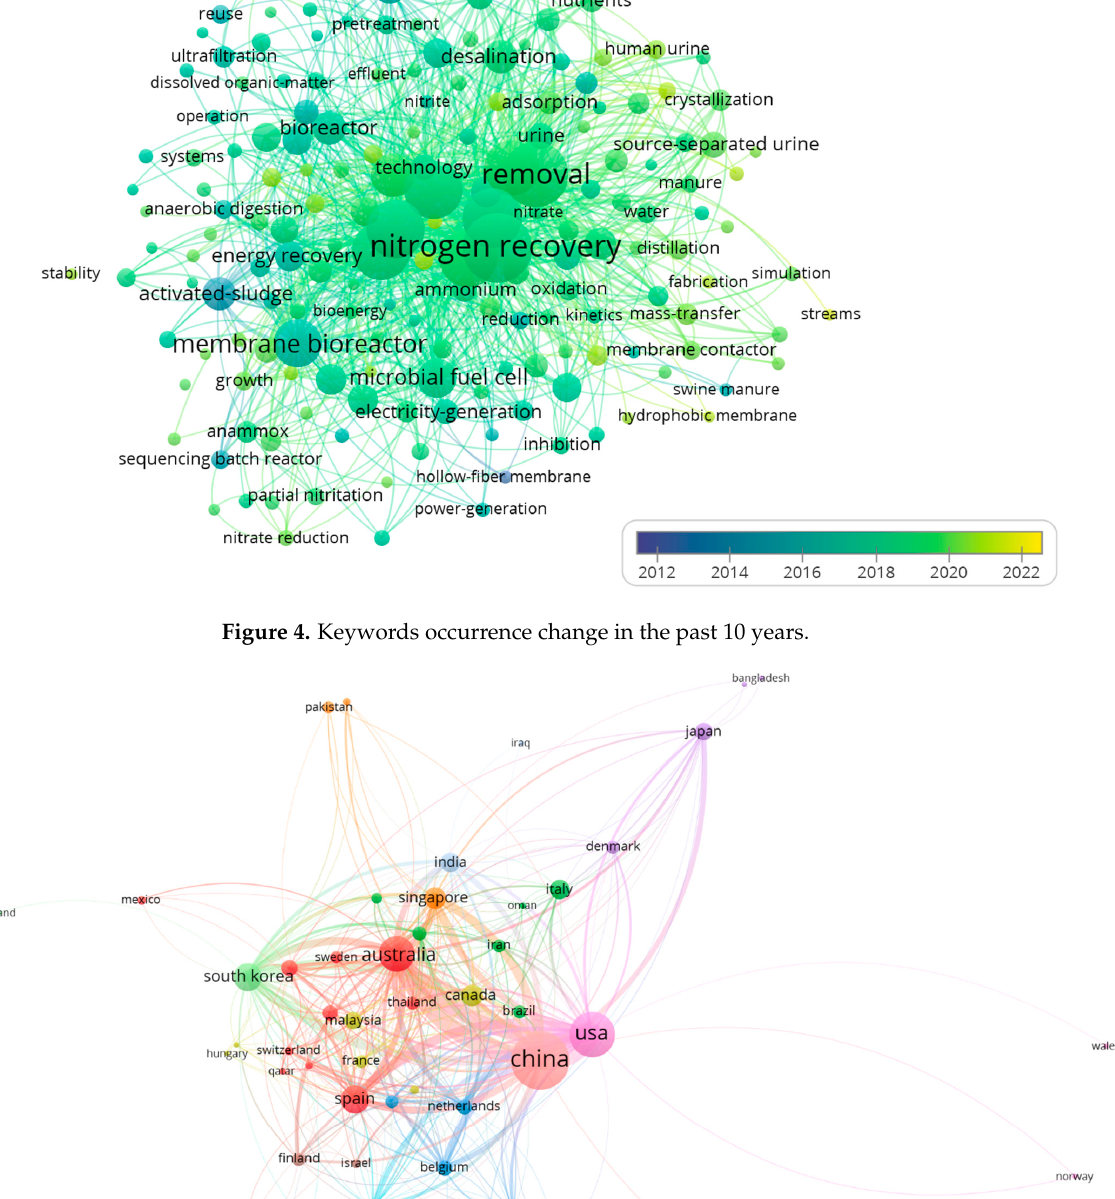
Figure 6. Co-authorship map based on the number of documents. 3. Nitrogen Recovery Waste Streams This section is concerned with discussing the potential nitrogen recovery waste streams. The various streams that have proven to be valuable sources of nitrogen recovery are presented in Table 2. Several factors affect nitrogen recovery from wastewater, such as the concentration of reactive nitrogen (i.e., NH 4 ⁺ ), solids concentration in the stream, and other characteristics including pH level and the concentration of organic and inorganic constituent contaminants. The organic concentration is expressed commonly in chemical oxygen demand (COD) units or total organic carbon (TOC). Total dissolved